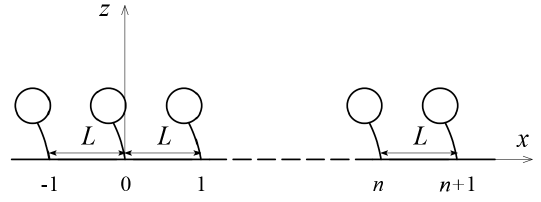
Figure 2. A surface with an array of dipole resonators.